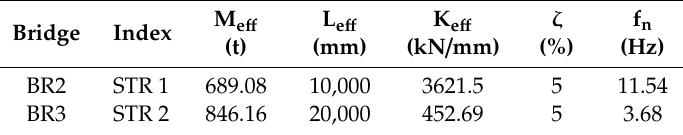
Table 2. Summary of equivalent SDOF model.